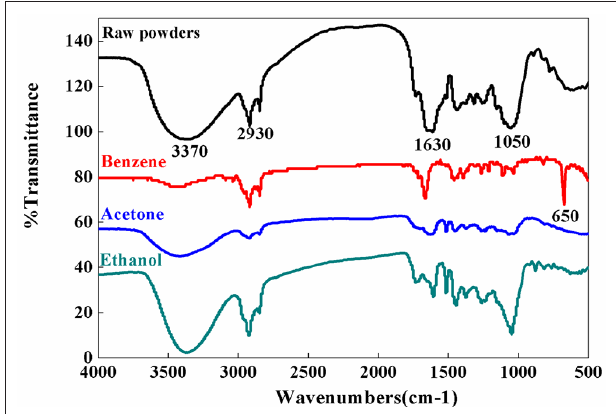
FIGURE 2 | The FTIR results of the raw powder and three solvents from C. camphora leaves.